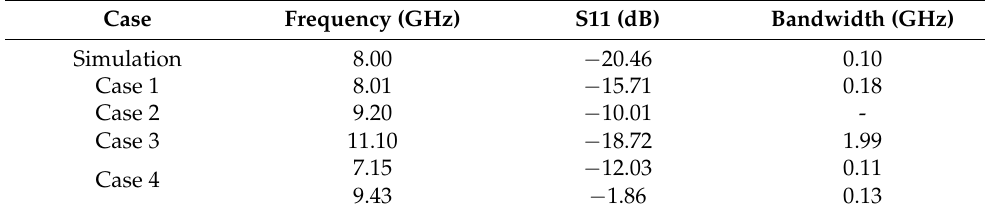
Figure 6. The measured and simulated reflection coefficients for the proposed four antennas. ( a ) Case 1, ( b ) case 2, ( c ) case 3 and ( d ) case 4. Table 3. Measured and simulated resonant frequencies, the corresponding reflection coefficients and − 10 dB bandwidths of the antennas.